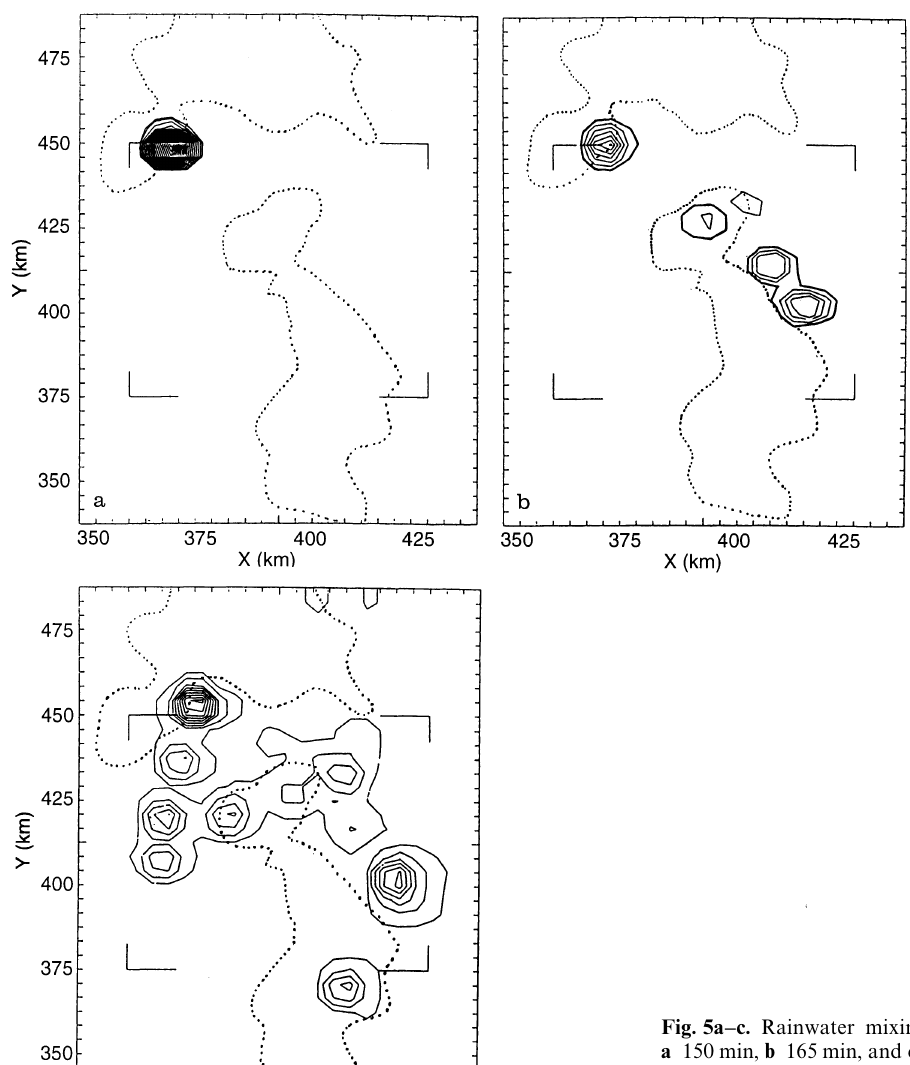
Fig. 5a (cid:177) c. Rainwater mixing ratio, q (cid:82) , at 2 km for SET I after a 150 min, b 165 min, and c 180 min. The dotted outline represents the 250 m topography contour line. The q (cid:82) contour interval in a is 0.00781 g/kg, and in b and c 0.0625